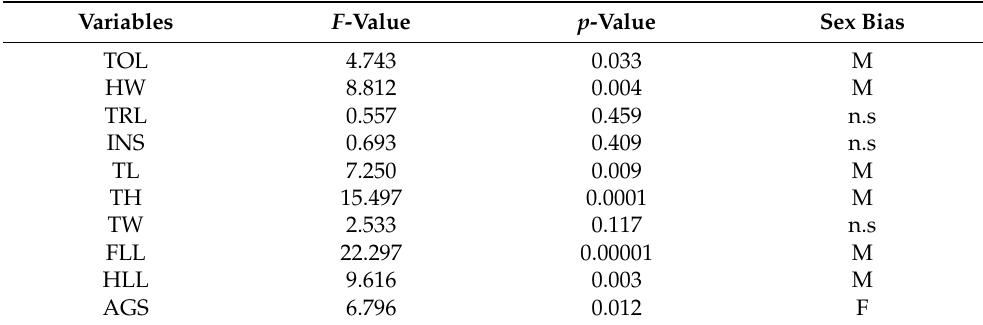
Table 3. Analysis of sexual shape dimorphism in H. maoershanensis . Results of one-way ANCOVA comparing 10 traits of the sexes relative to